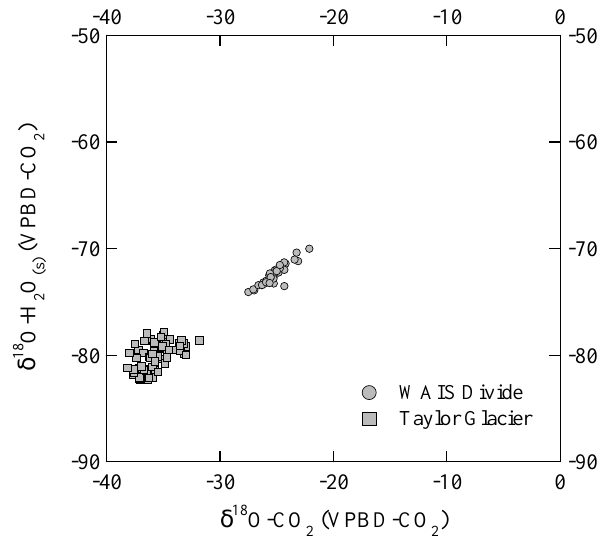
Figure 7. δ 18 O-CO 2 and δ 18 O-H 2 O correlation: δ 18 O-CO 2 plot- ted against δ 18 O-H 2 O from the WAIS Divide and Taylor Glacier